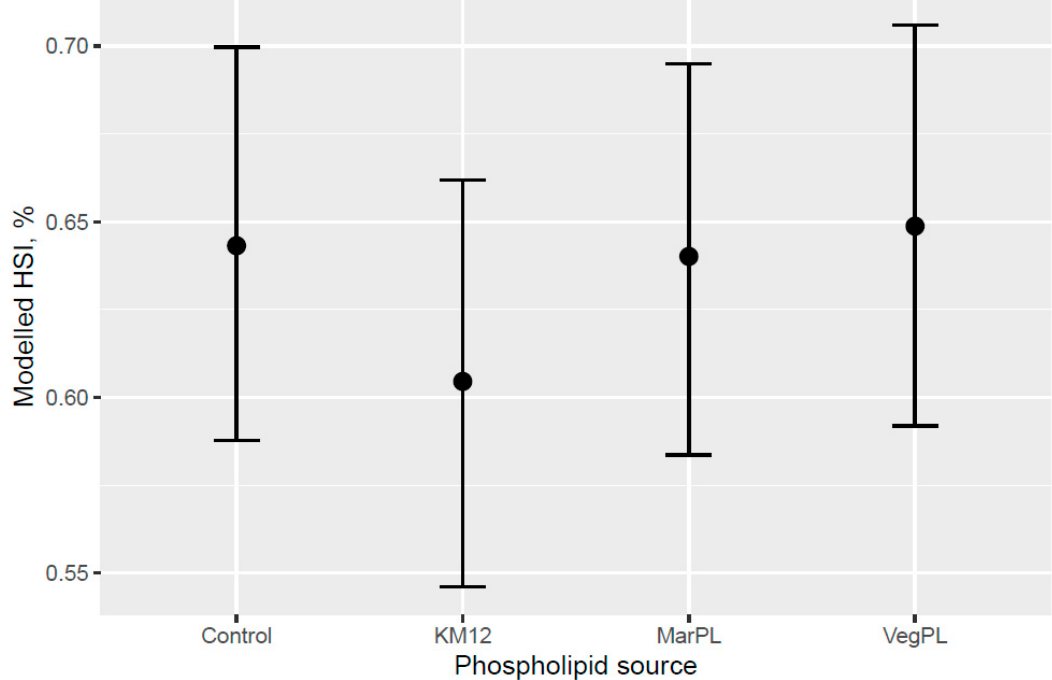
Figure 9. Modelled hepatosomatic index (HSI) for different phospholipid sources after 53 d of feeding in the freshwater pre-transfer phase plotted with 95% credible intervals. HSI is derived from the model for a 157 g average-sized sampled